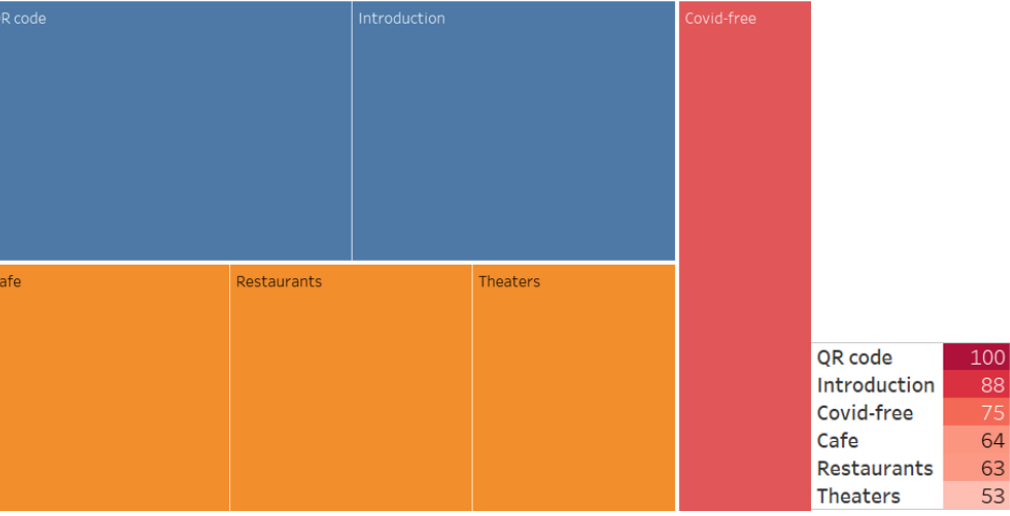
Figure 11. Associative network of the “QR codes” stimulus in the negative cluster.